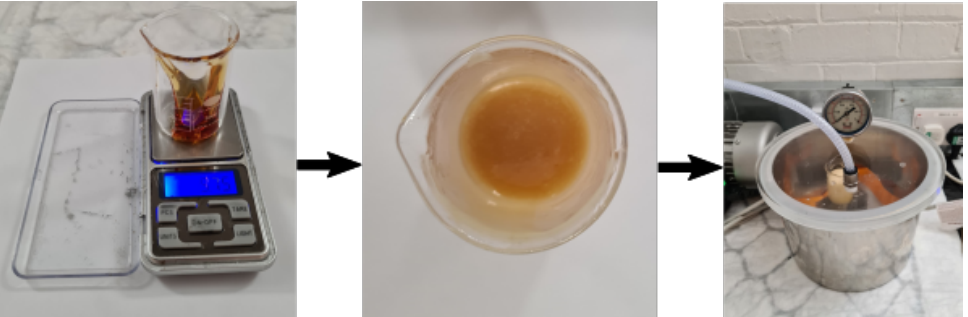
Figure 4. Synthesis of the self-healing polymer. First the correct amount of the different reagents (FT3000, BMI1400, 4TBC) has to be weighed ( left ). Afterwards, they need to be mixed well ( centre ). This creates trapped air bubbles, which are removed in a degassing step ( right ). A more detailed description of the synthesis can be found in the accompanying instruction